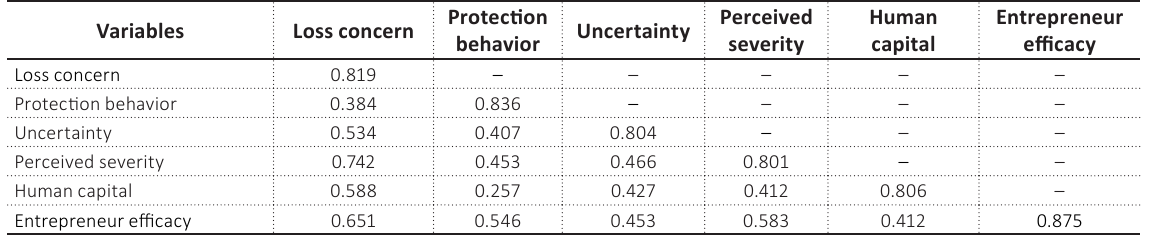
Table 3. Discriminant validity